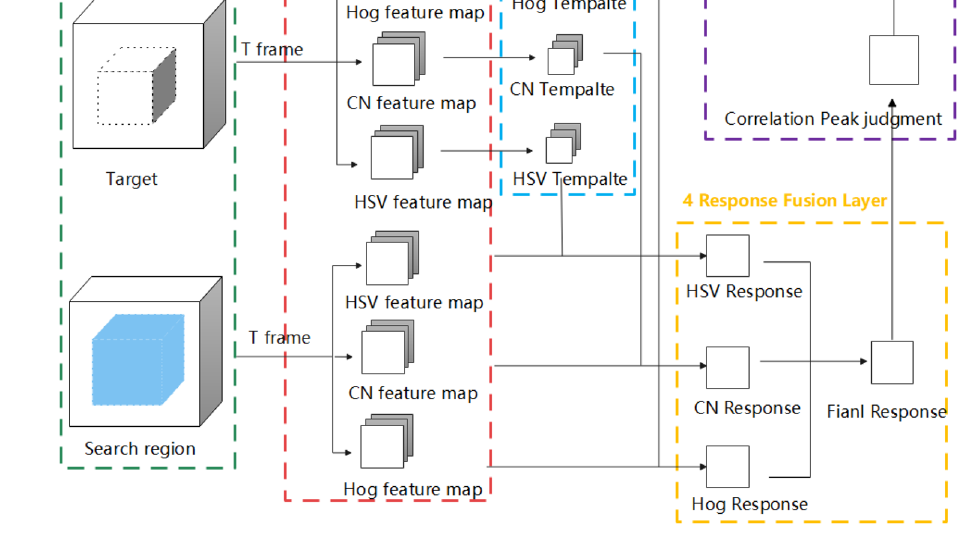
Fig. 1 Algorithm flowchart. The algorithm structure is roughly divided into three main parts: (1) feature extraction and fusion, (2) template and response calculation and (3) template update